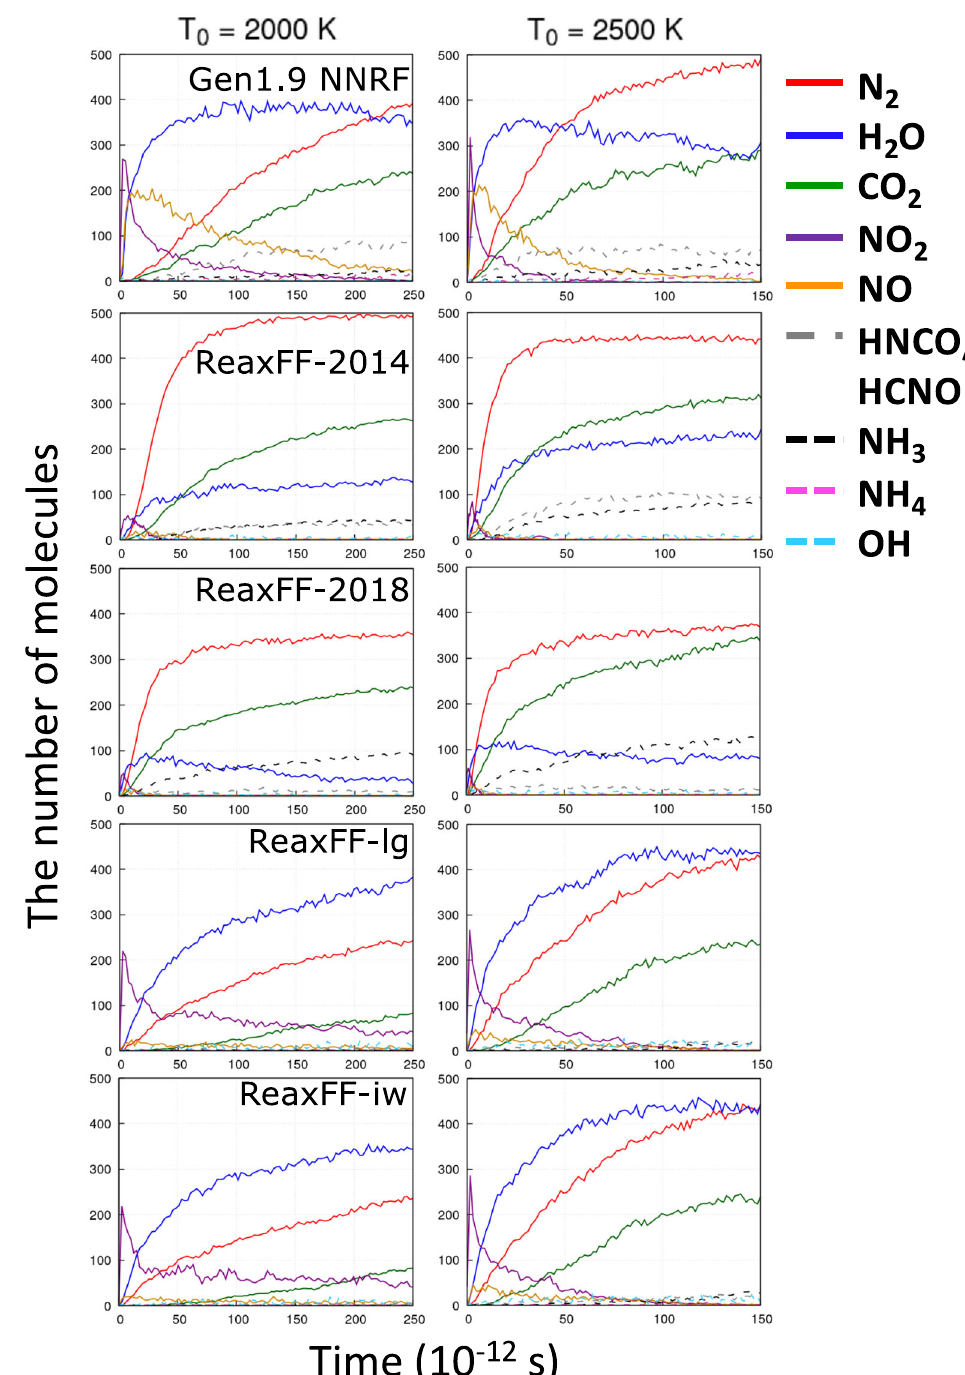
Fig. 9 Chemical species evolution of thermal decomposition of RDX system. Chemistry comparison between Gen1.9 NNRF and the four parameterizations of ReaxFF. NNRF is the force fi eld to get majority of N 2 similar to ReaxFF-2014 and ReaxFF-2018 as compared to H 2 O in ReaxFF-lg and